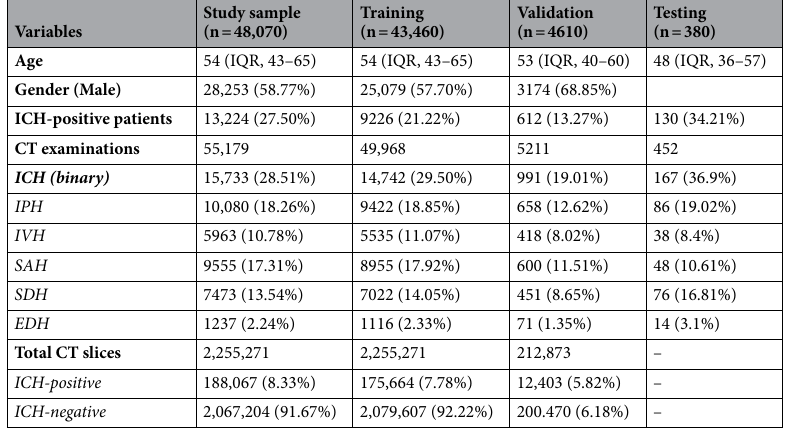
Table 1. Characteristics of the study sample. * EDH epidural hemorrhage, ICH intracranial hemorrhage, IPH intra-parenchymal hemorrhage, SAH subarachnoid hemorrhage, SDH subdural